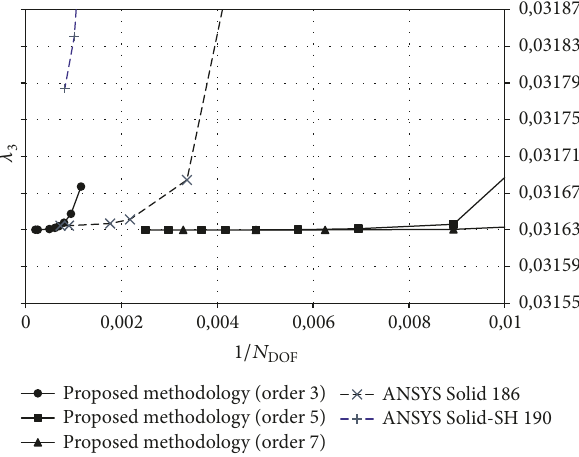
̂𝜆 1/𝑁 ℎ -convergence). 4 versus DOF (